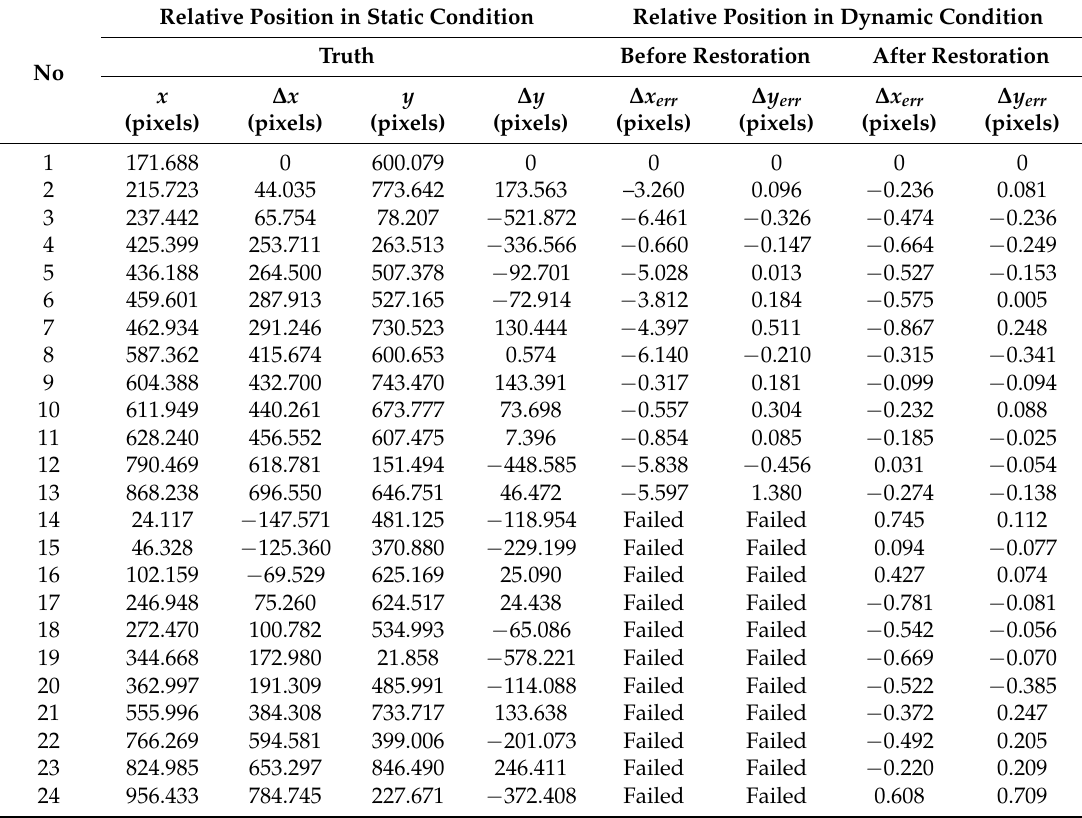
Table 4. Centroid position error before and after